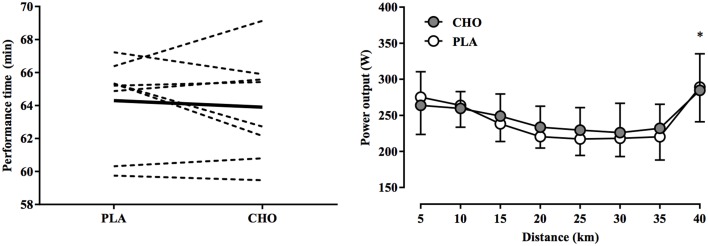
Individual differences in performance time (left) and mean power output at 5-km intervals (right) during a 40-km cycling time trial in hot and humid conditions while swilling either a 6.5% carbohydrate solution (CHO) relative to performance time with a placebo solution (PLA) matched for color and taste. For individual performance times, thin dashed and thick black lines indicate individual and mean differences in performance time, expressed as a absolute change from the PLA treatment, respectively. No significant treatment-by-time interaction was observed; * indicates main effect of time (P < 0.01).